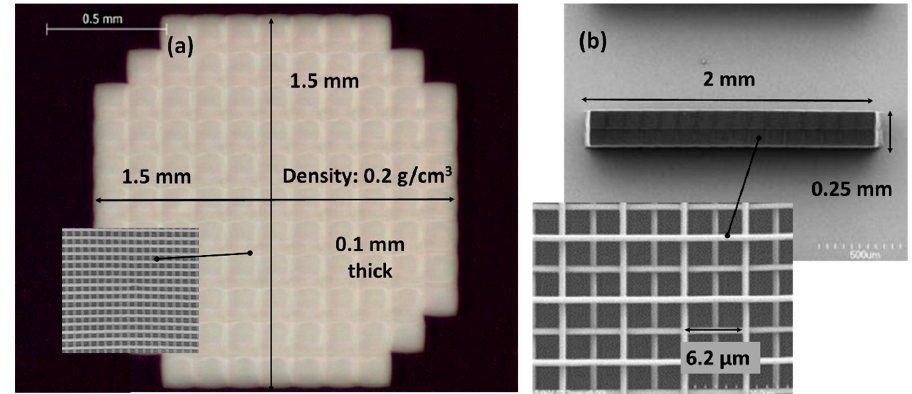
Figure 1. Examples of ( a ) foam plate and ( b ) a rod of two-photon polymerization (2PP) fabricated log-pile structures for laser target applications. The foam plate: 1.5 × 1.5 × 0.10 mm 3 with a 4 × 4 × 2 μ m 3 beam lattice structure (density ~0.2 g/cm 3 ). The foam rod: 2.0 × 0.25 × 0.35 mm 3 with a 6.2 × 6.2 × 1.0 μ m 3 beam lattice structure (density ~0.1 g/cm 3 ).